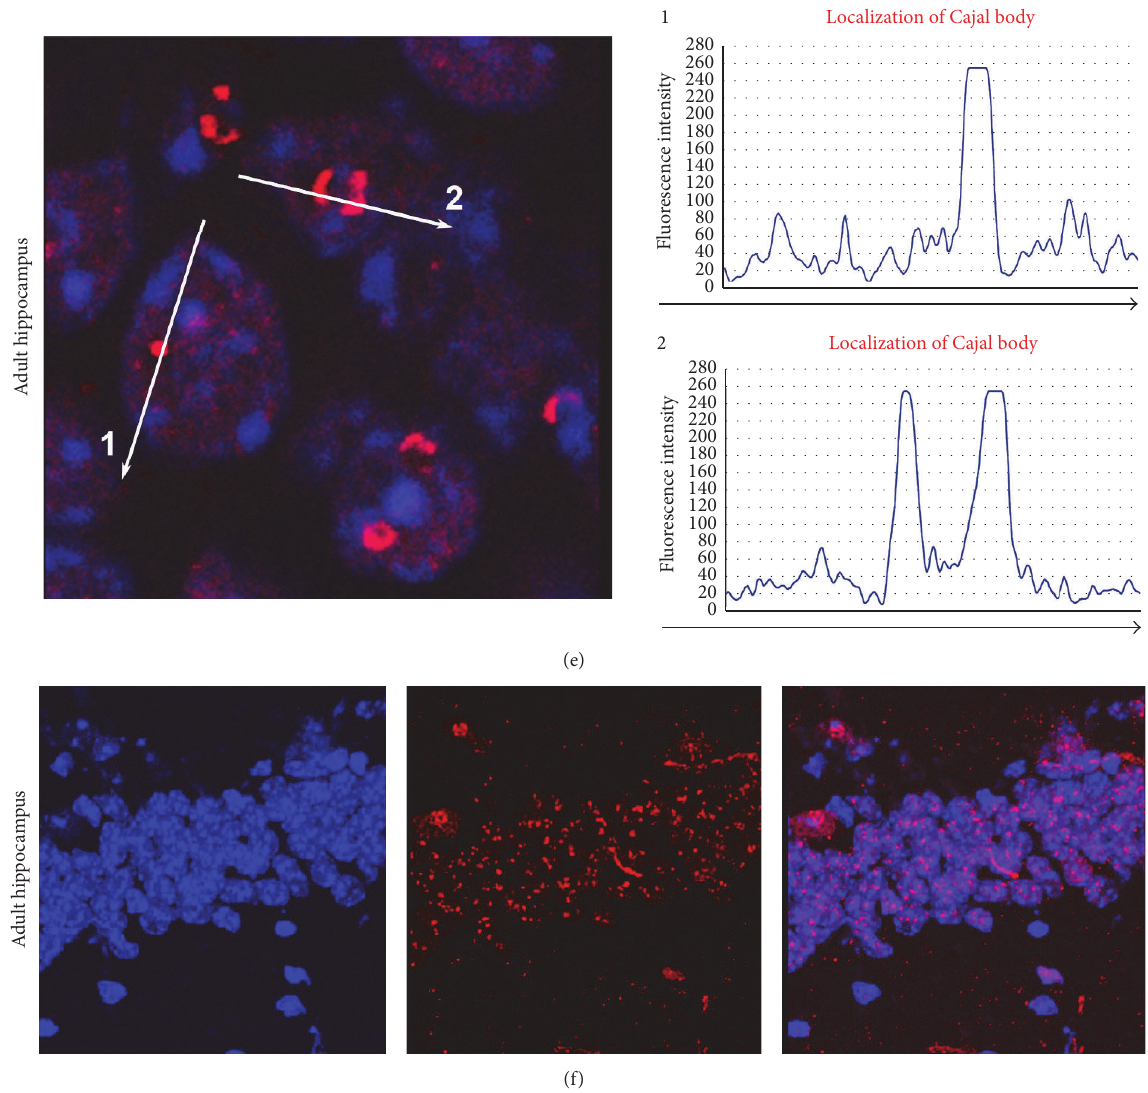
Figure 2: The nuclear distribution patterns of coilin in adult mouse brain sections. (a) shows the chondroid plexus of the lateral ventricle. (b) Coilin distribution in the cortex periphery of an adult brain. ((c)(A), (c)(B)) Hippocampal regions visualized by hematoxylin-eosin staining, an image from the brain atlas (see [31]). (d–f) Accumulation of coilin in crescent-like foci in the hippocampal region of an adult brain. DAPI staining is used to visualize cell nuclei. Coilin (red) was labeled by a secondary antibody conjugated with Alexa 594. Nuclear distribution of coilin in cells 1 and 2 (e) is shown in graphs 1 and 2. Fluorescence intensity along white lines with arrows was measured using the Image J software (NIH freeware). (f) shows a high density of coilin in the hippocampus (hippocampal blade) of an adult mouse